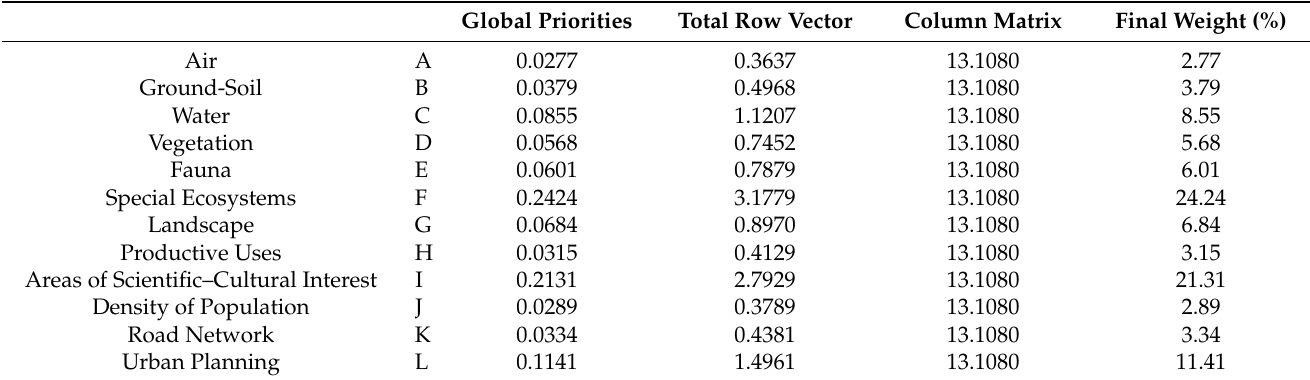
Table 9. Results of the normalized matrix of pairwise comparison (fifth